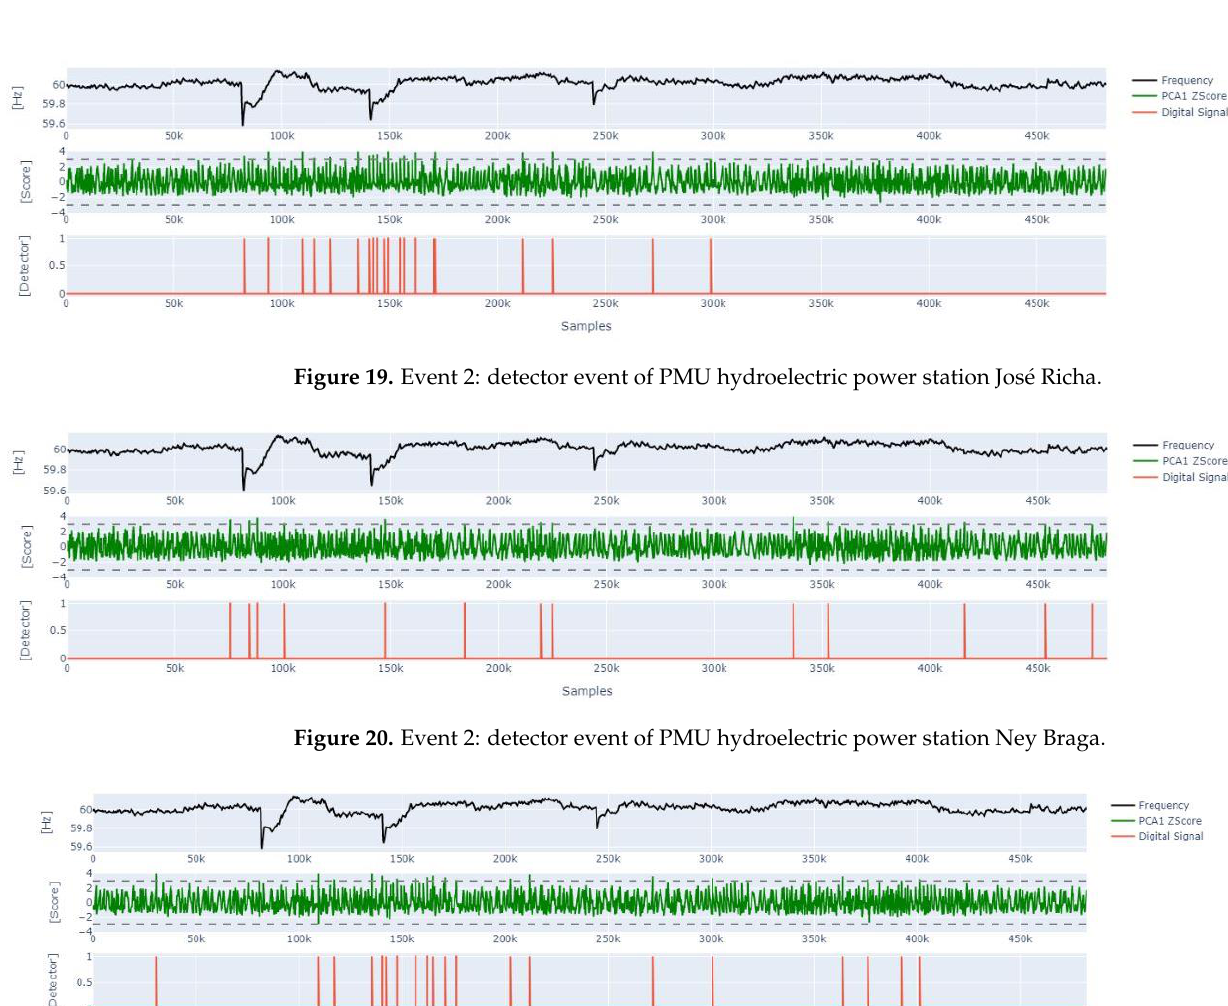
Figure 18. Event 2: detector event of PMU Araraquara (located at São Paulo State).